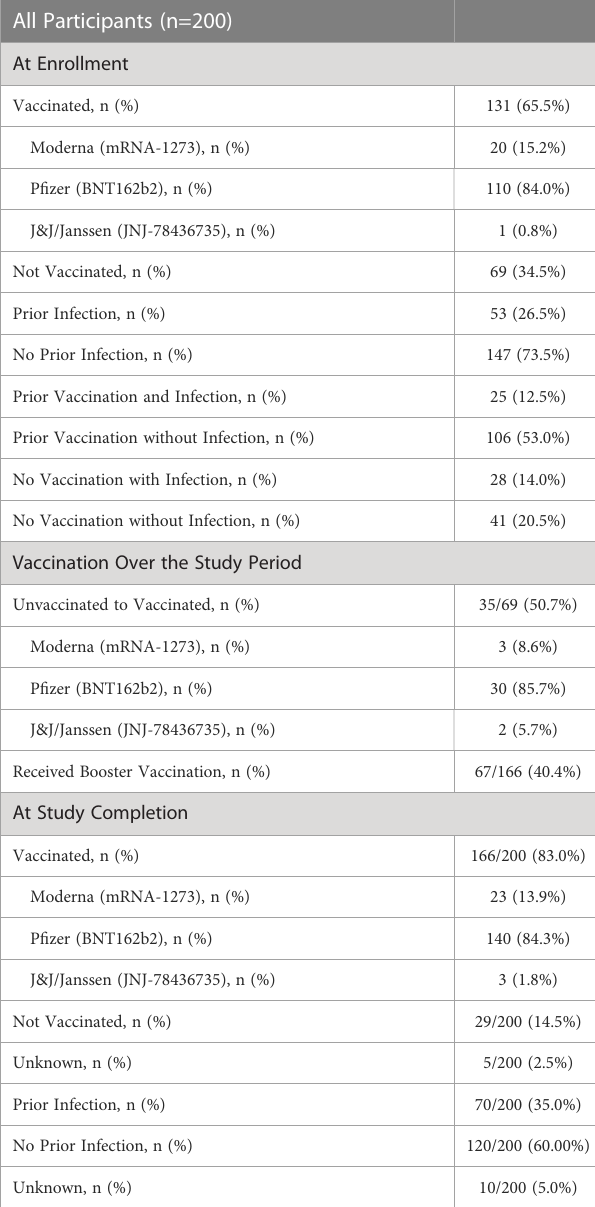
TABLE 2 Participant serological status at enrollment and over the study